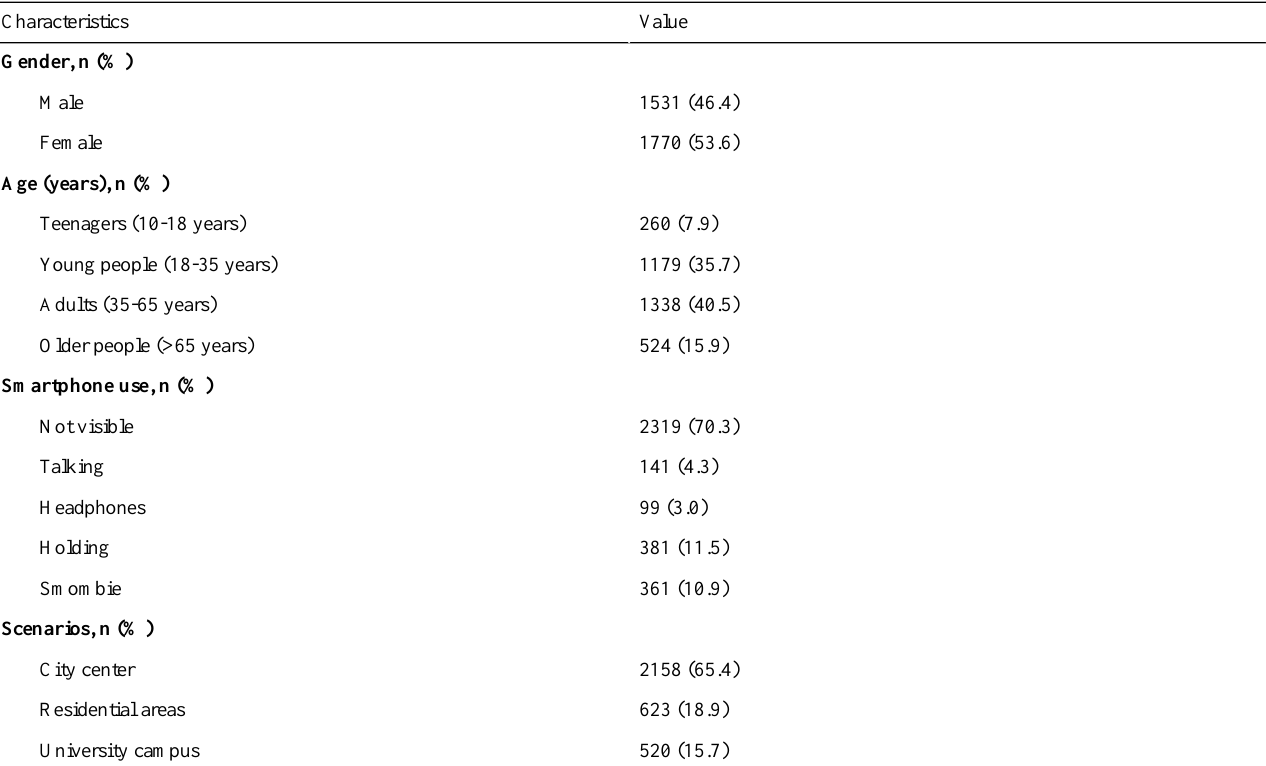
Table 1. Demographic characteristics of the observed pedestrians in the study (N=3301).